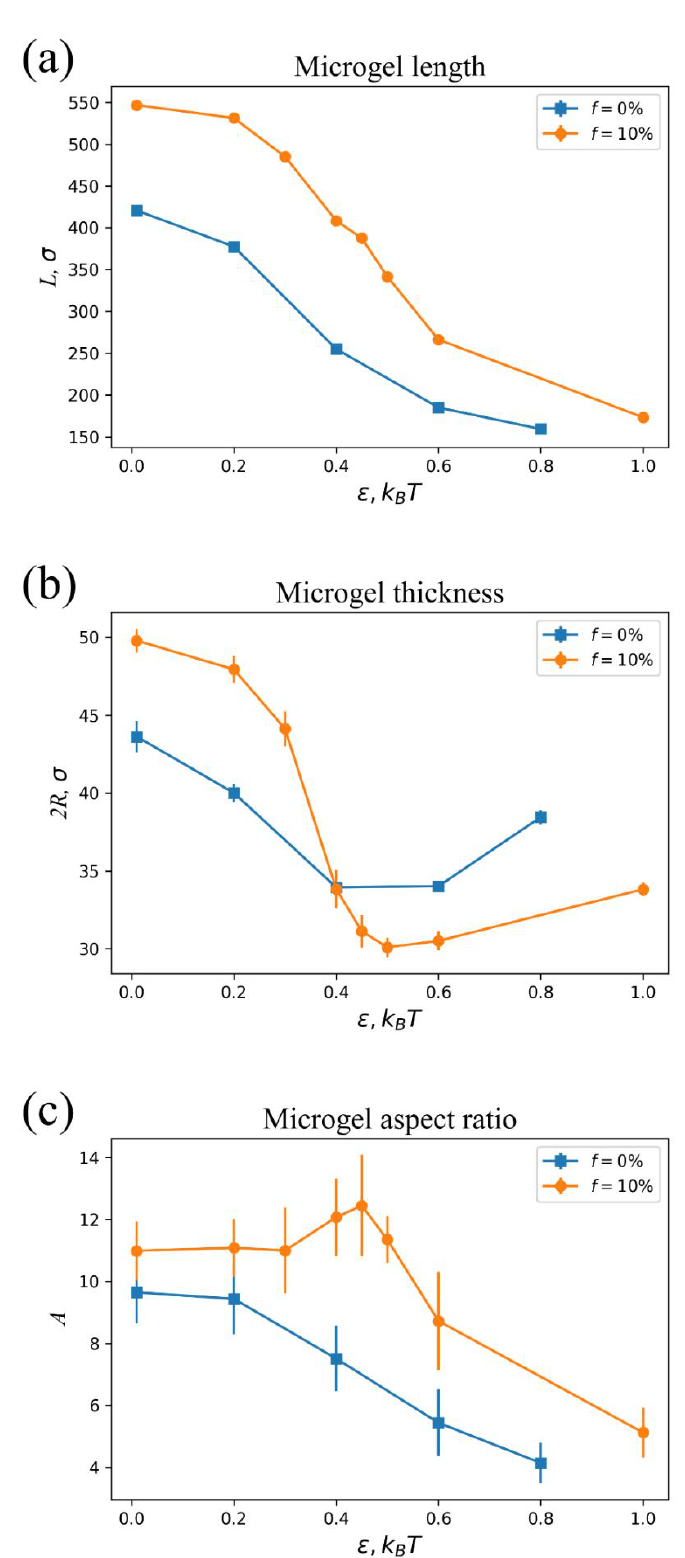
Figure 2. Contour length L ( a ), thickness 2 R ( b ), and aspect ratio A = L /2 R ( c ) of equivalent neutral ( f = 0%) and charged ( f = 10%) microgels as functions of the interaction parameter ε . The molecular weight and subchain length of the microgels are N = 100,000 and M = 10, respectively. The initial aspect ratio of the microgels is A = 10.